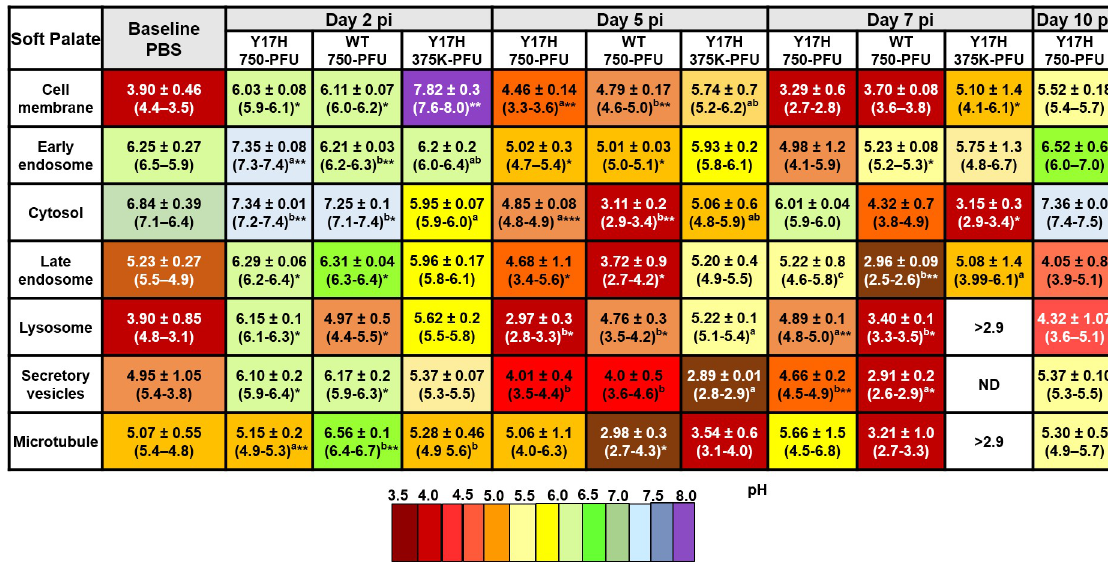
Fig 7. Intracellular pH values of individual uninfected and infected live epithelial cells isolated from the soft palate tissues of DBA/2J mice. Mice were intranasally inoculated, and cellular pH values were determined as described in Fig 6.